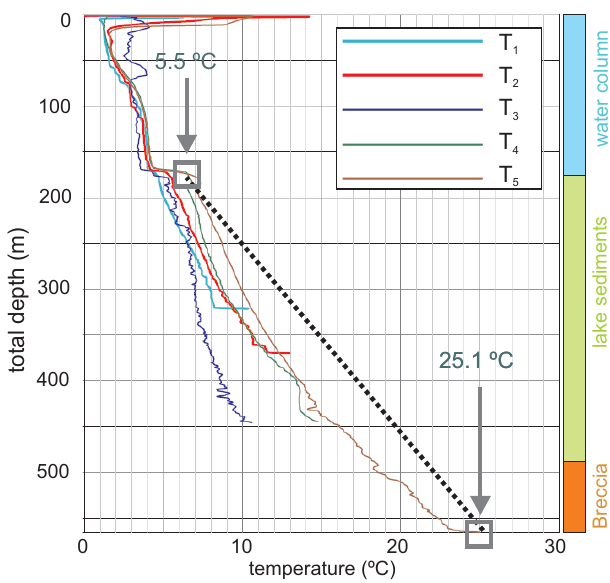
Fig. 4. Temperature logs in borehole ICDP site 5011-1. T 5 is the most reliable, and thus is used for estimating the temperature gradi- ent (data by ICDP-OSG,